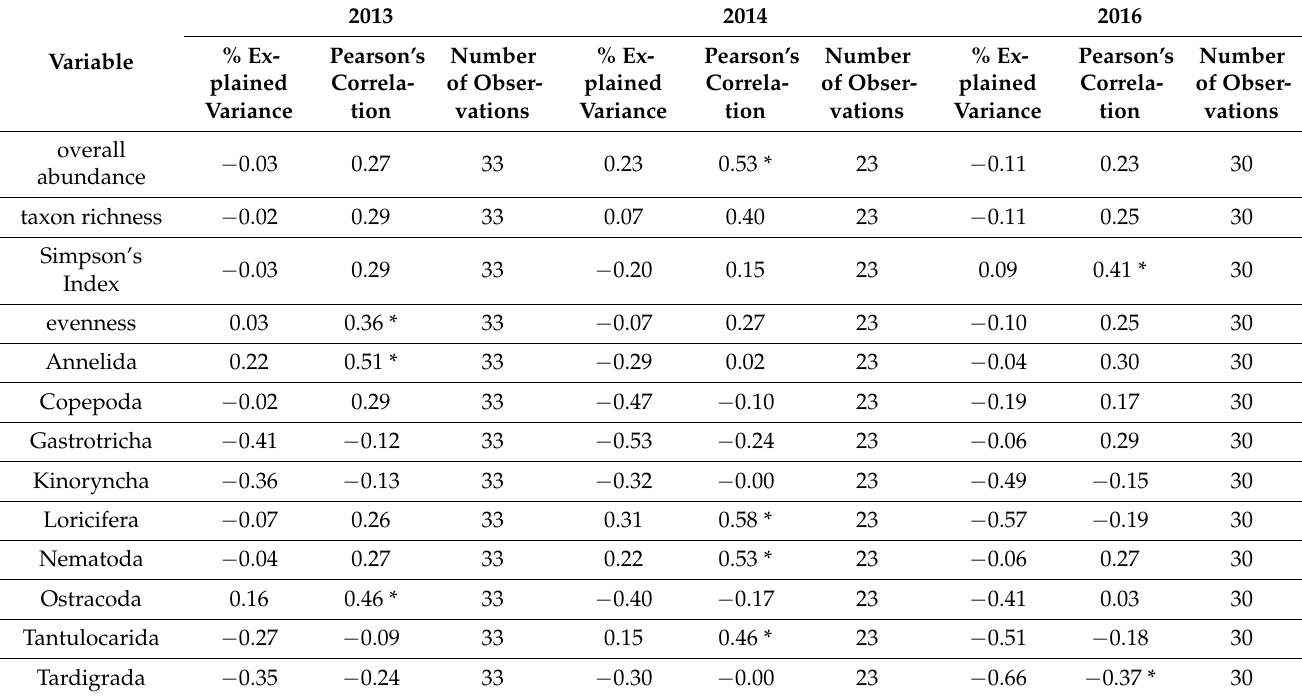
Table 5. Model evaluations of the random forest regressions computed for overall meiofauna abundance, taxon richness and diversity, as well as different higher meiofauna taxa, integrating only data obtained in 2013, 2014 and 2016 according to the percentage of explained variance and Pearson’s correlation (* indicating